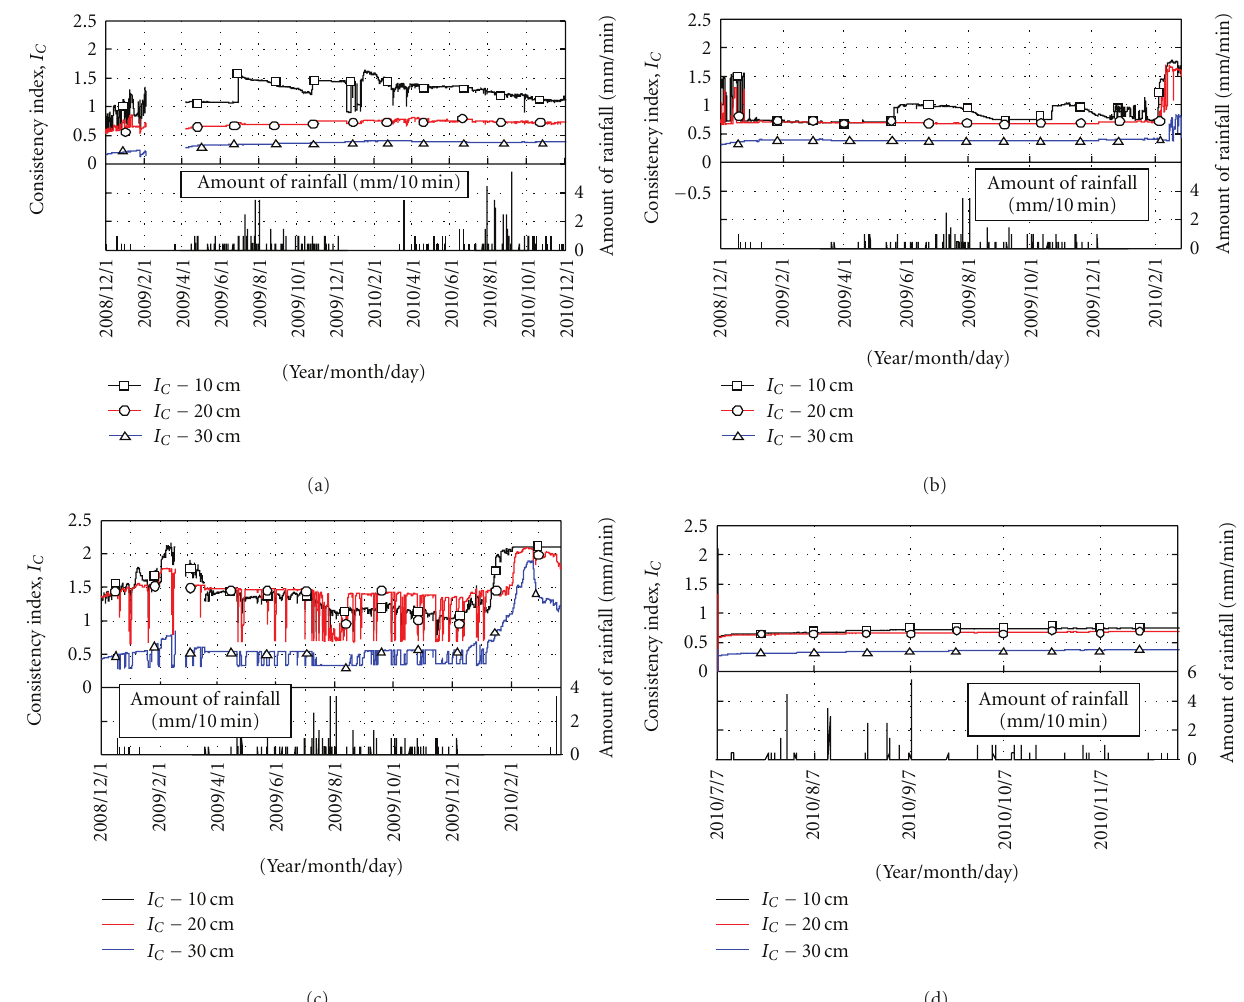
Figure 10: Changes in consistency index, I C , for each depth; (a) soil moisture meter 1, (b) soil moisture meter 2, (c) soil moisture meter 3 and (d) soil moisture meter